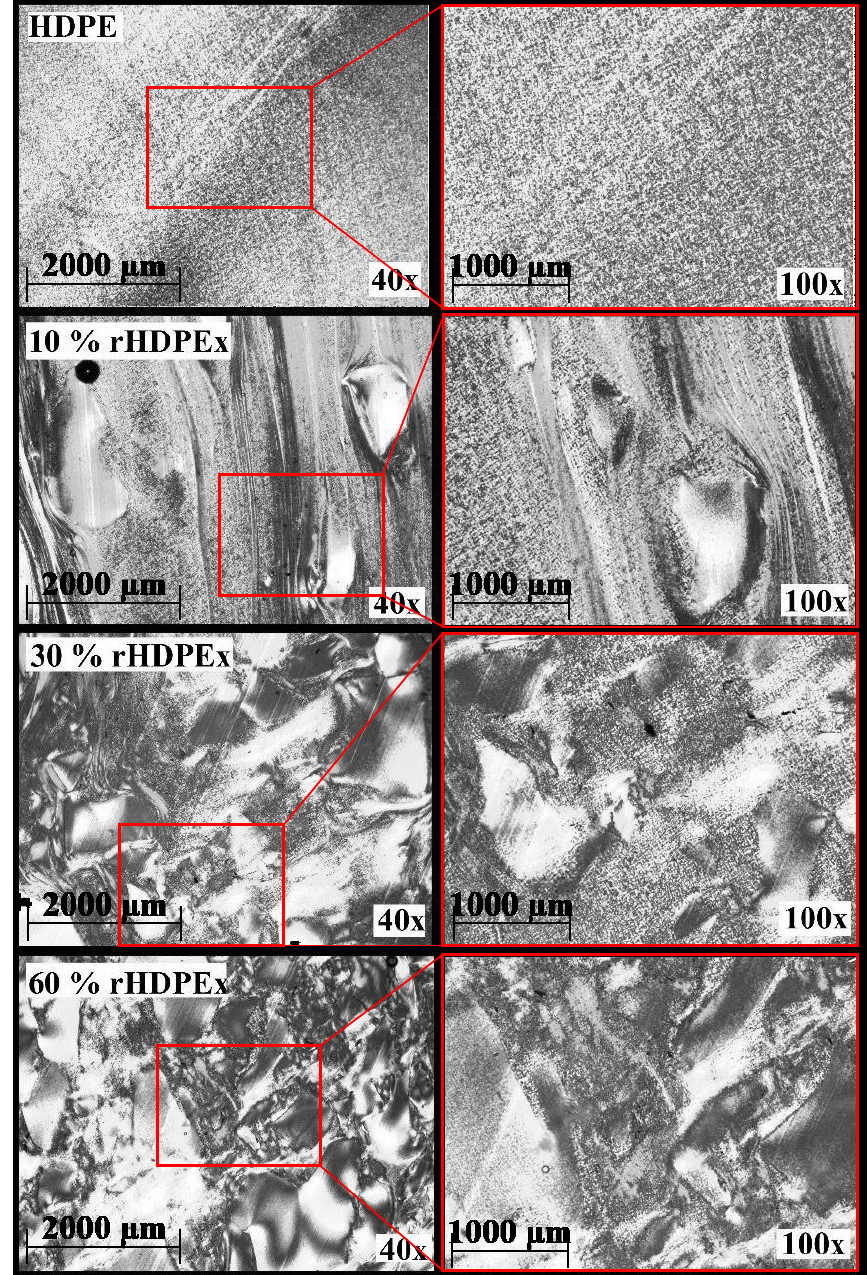
Figure 9. Microtome cuts of mixture